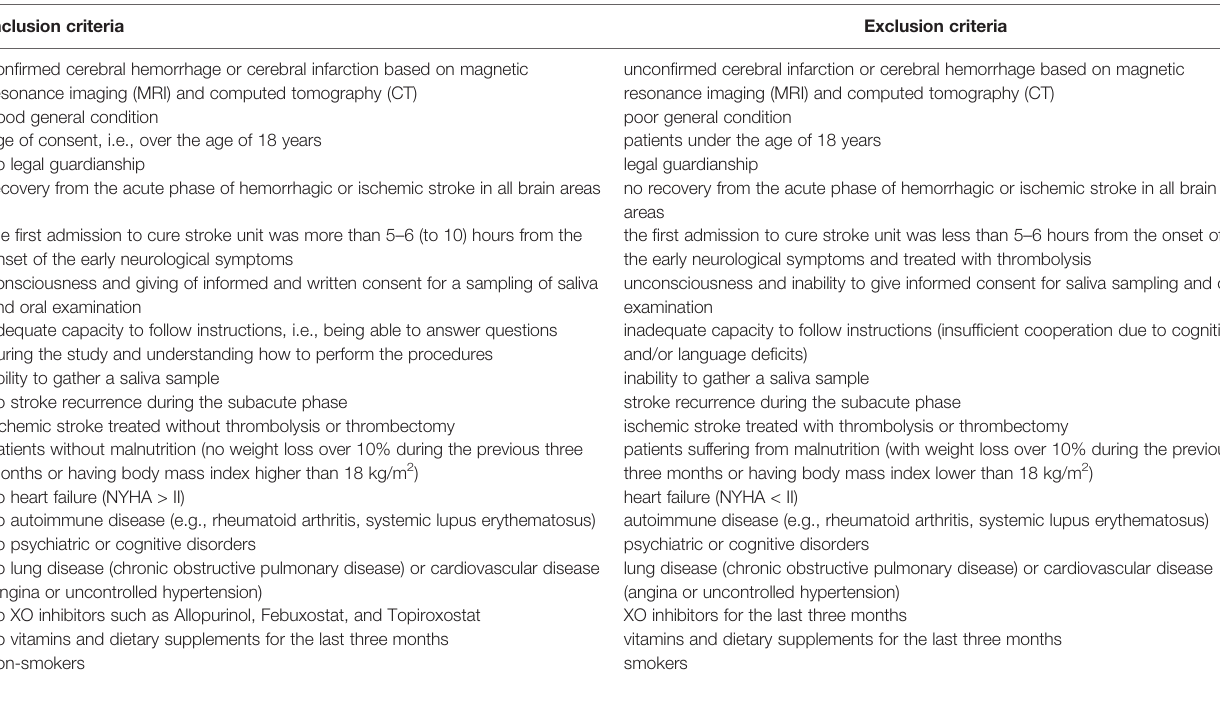
TABLE 1 | Inclusion and exclusion criteria for the subjects in the study